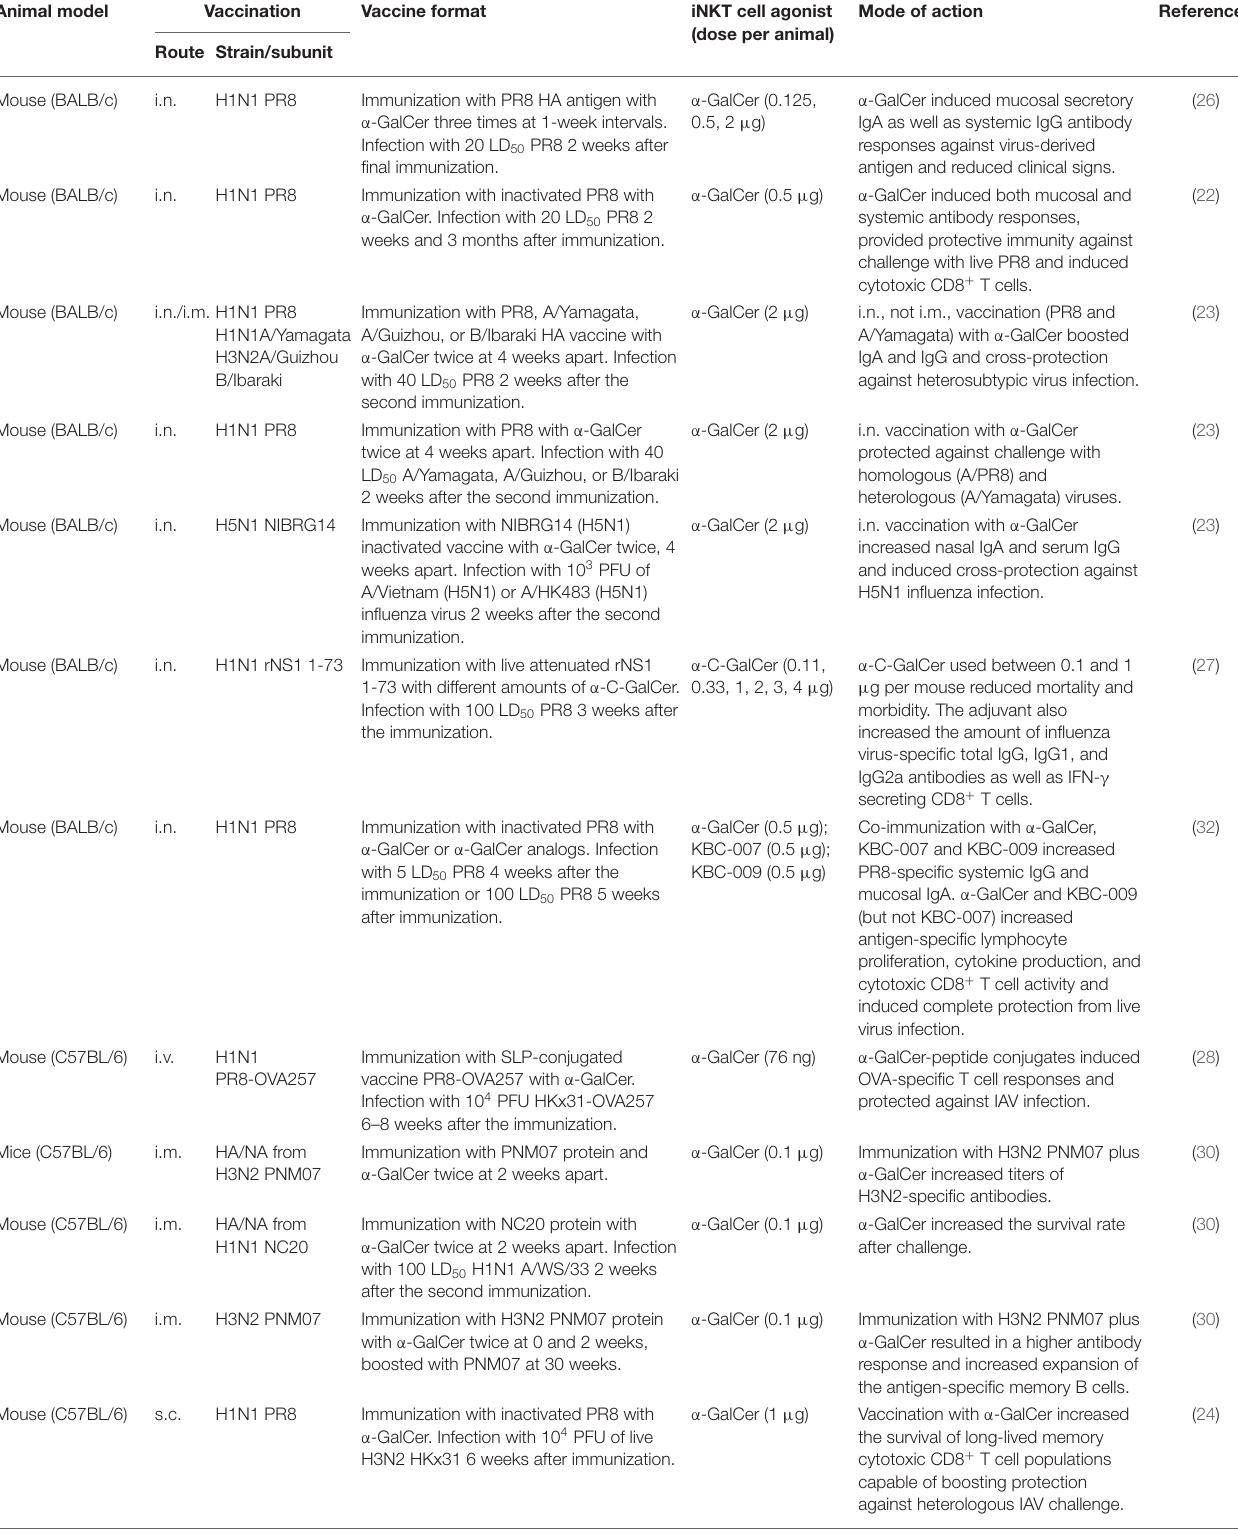
TABLE 1 | Summary of studies on modulating immune responses to influenza A virus (IAV) using invariant natural killer T (iNKT) cell agonists. Animal